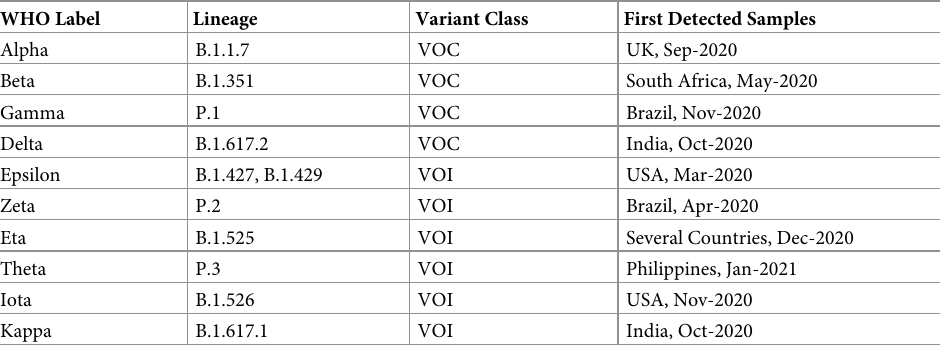
Table 3. Naming SARS-CoV-2 variants by World Health Organization (WHO)